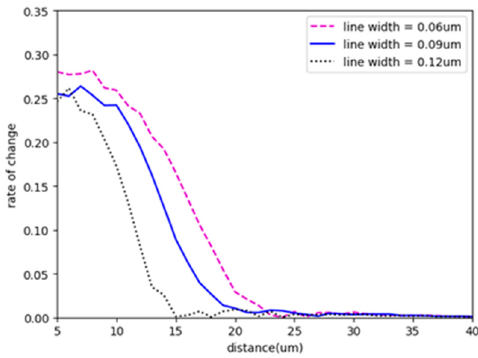
Figure 10. The effective planarization length test with 0.15 um gate spacing.